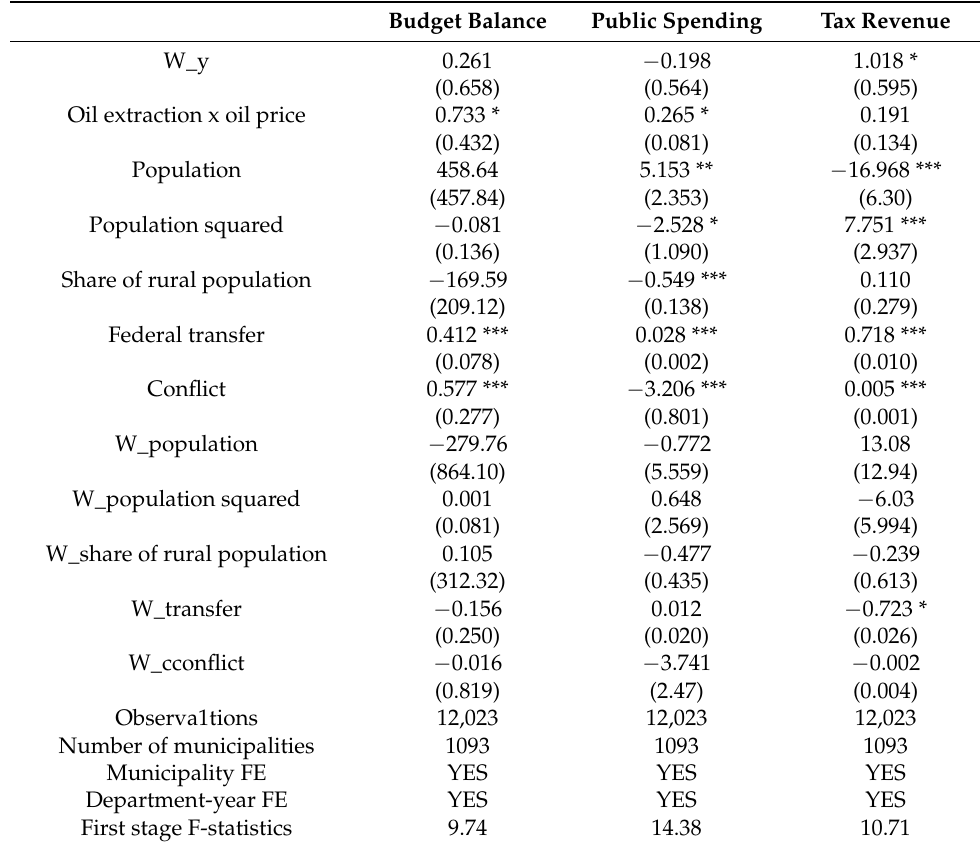
Table 3. Main IV estimation results for fiscal interaction from 2000–2010. Budget